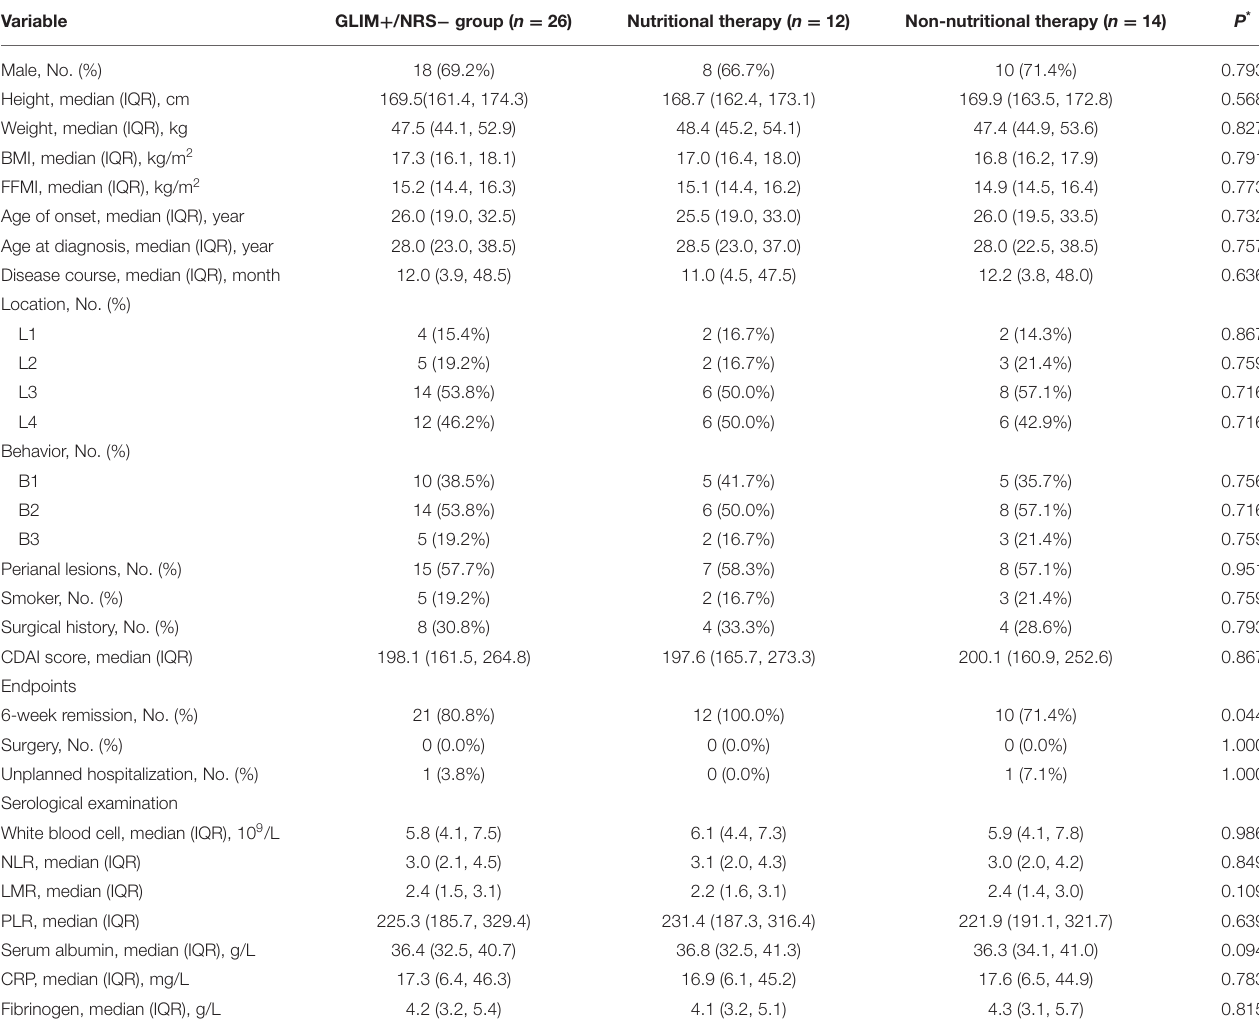
TABLE 6 | Comparison of GLIM + /NRS − patients with or without nutritional therapy. Variable GLIM + /NRS − group ( n = 26) Nutritional therapy ( n = 12) Non-nutritional therapy ( n = 14) P